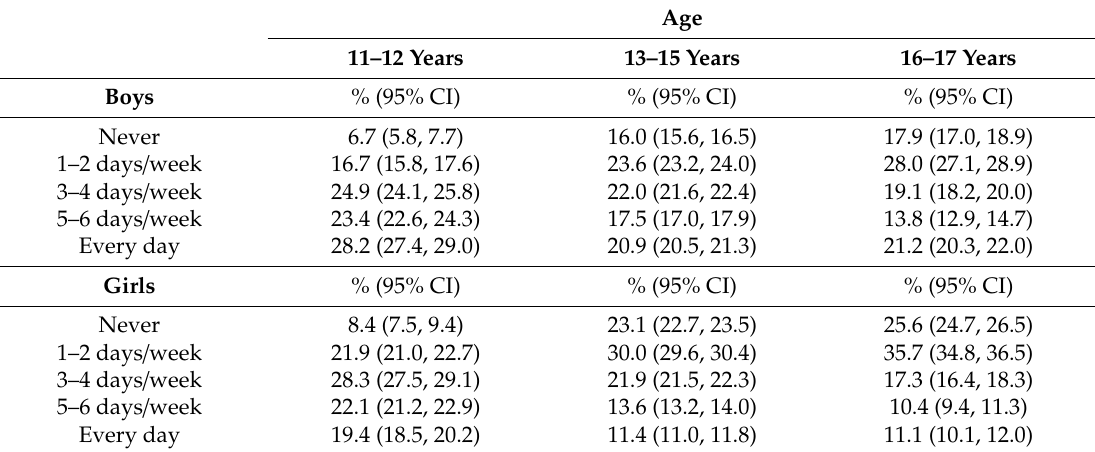
Table 2. Physical activity levels according to age, stratified by sex.